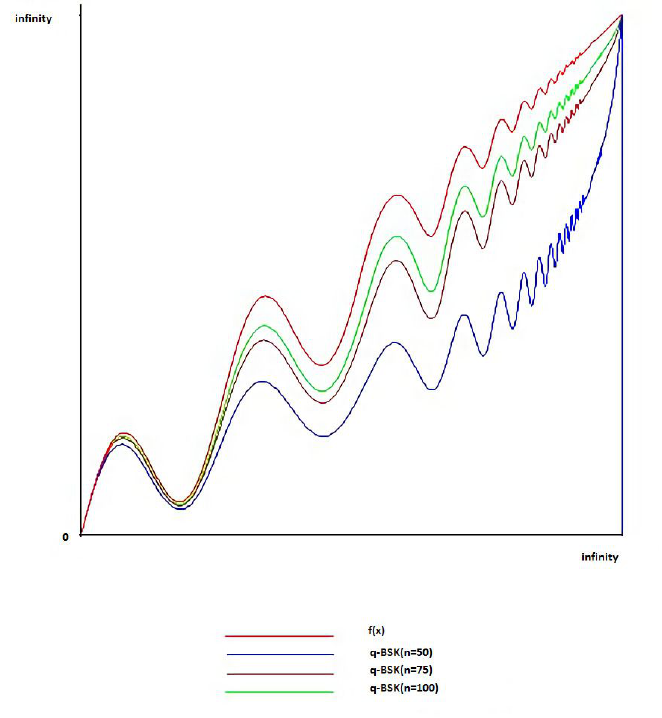
Figure 1: The convergence of the operators ˜ R n ( f ;0.95, x ) to f ( x ) for increasing values of n .